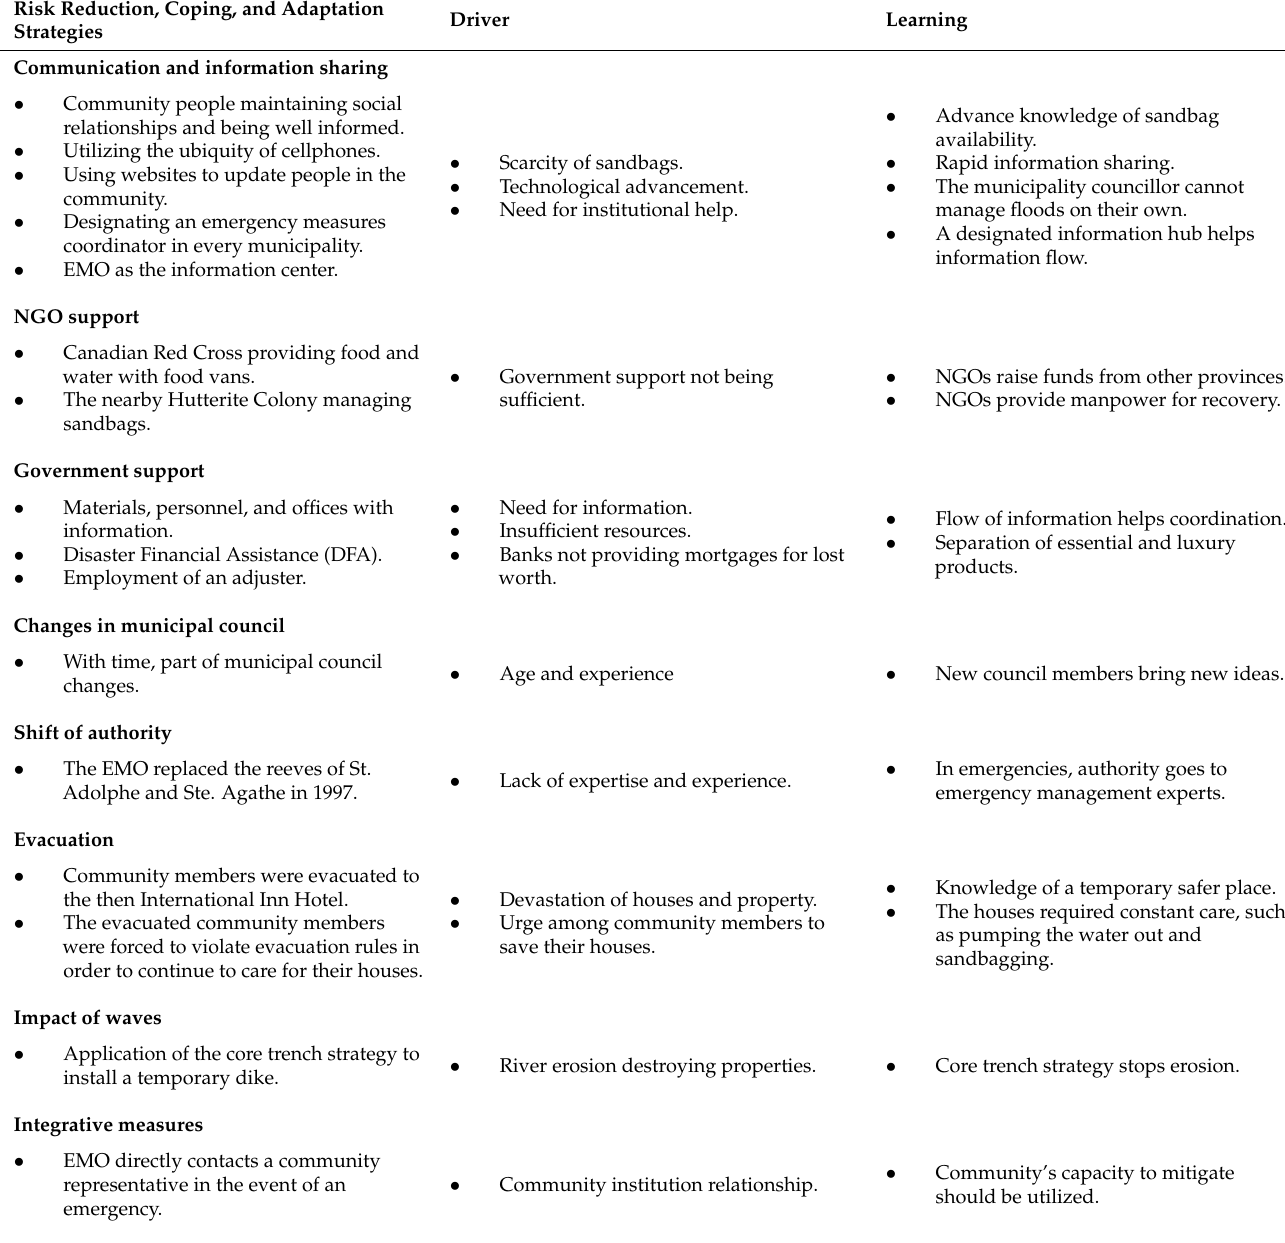
Table 3. Interaction between governments, NGOs, and communities for coping with and adapting to